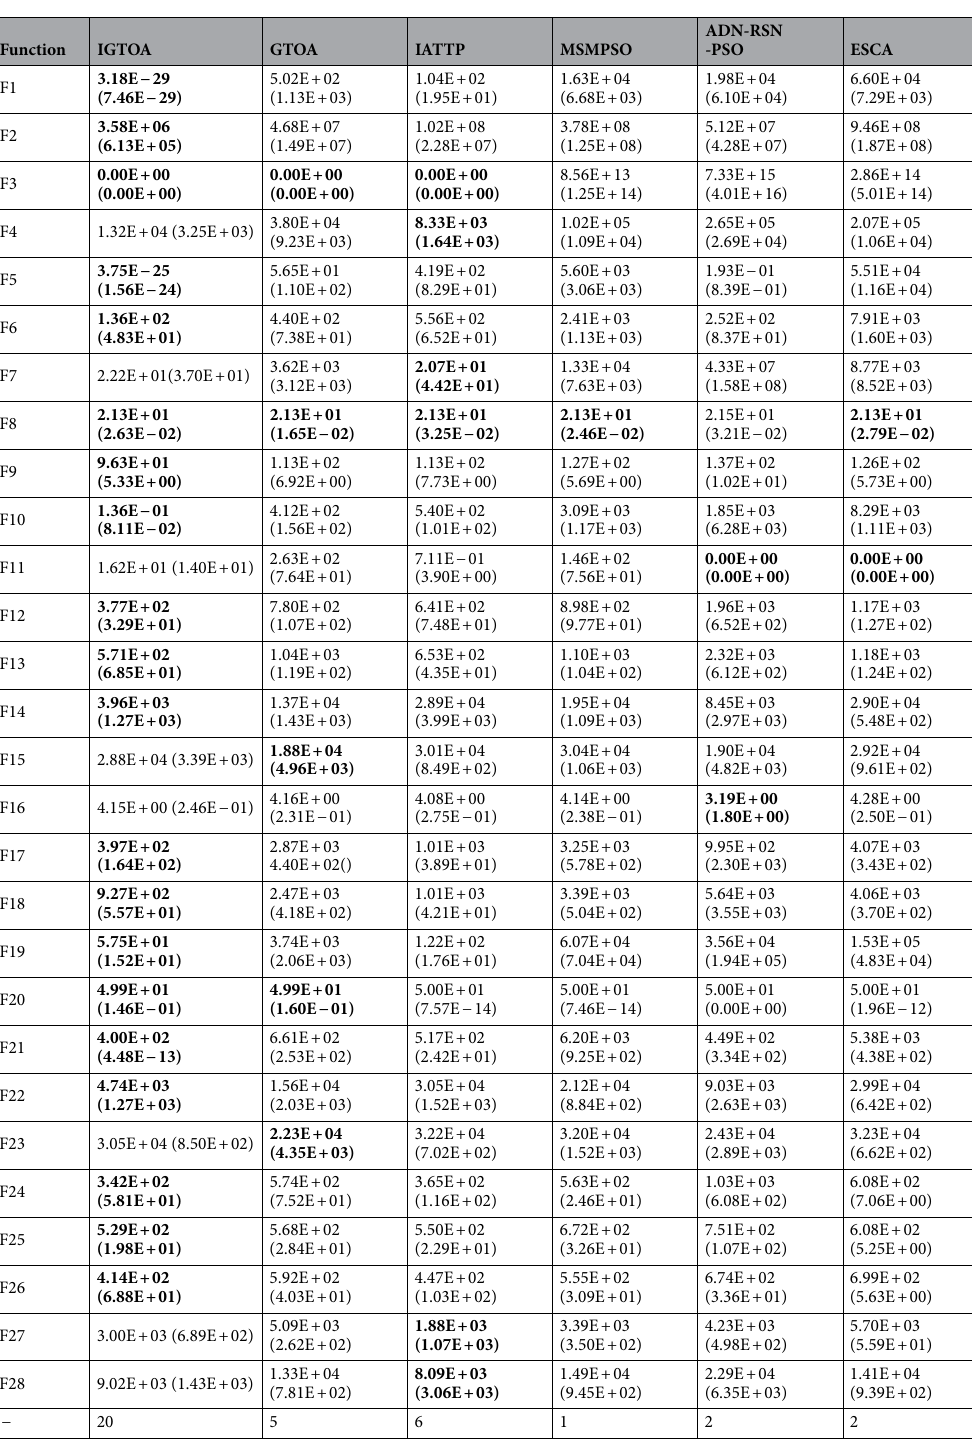
Table 6. Results of each algorithm on the 100-dimensional CEC2013 test set. Note: The parameters that perform best on each function are